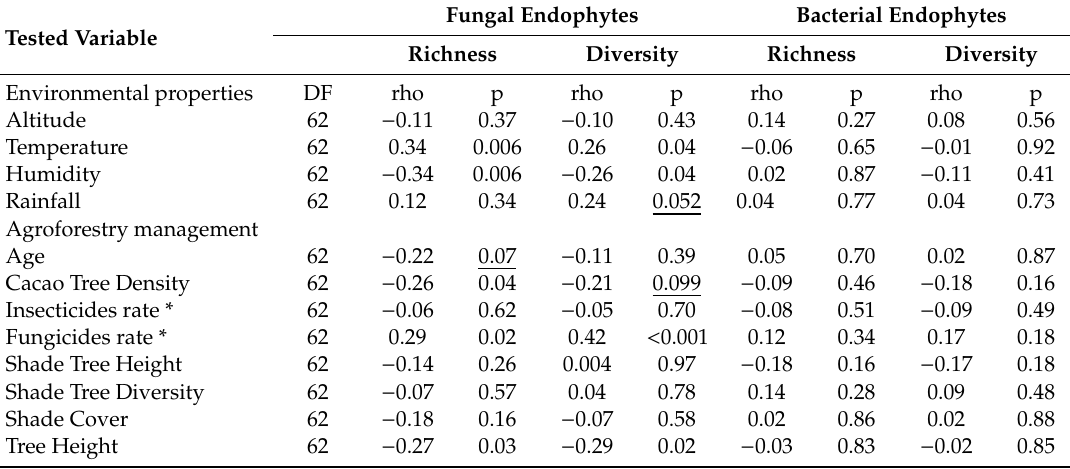
Table 4. Correlation between alpha diversity measures and environmental properties / an agroforestry management system based on Spearman’s rank correlation. Richness and diversity are represented by the number of observed zOTUs and Shannon diversity index H’,